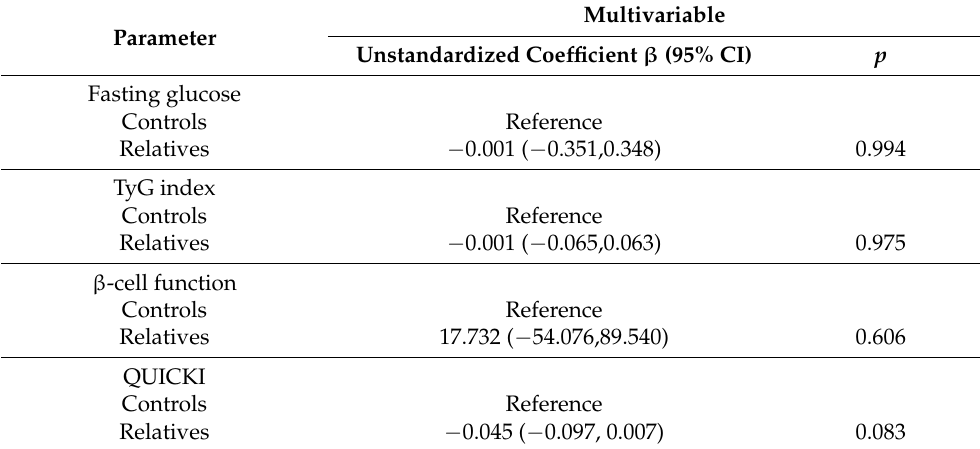
Table 9. Determinants of various parameters using multivariable linear regression analysis in control vs. spouses by age, sex and BMI